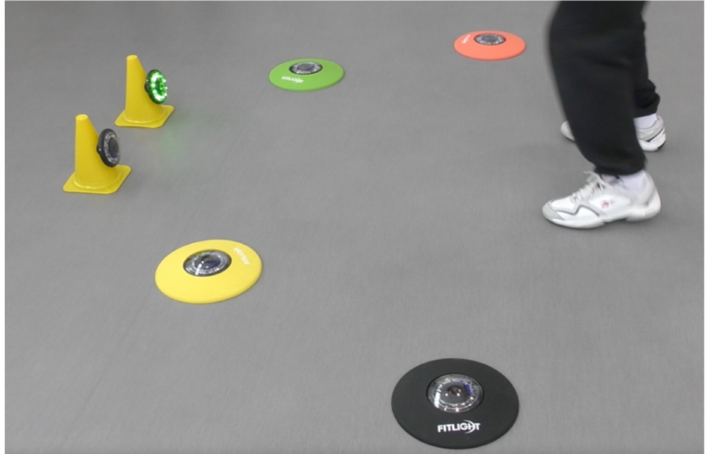
Figure 4. FitLight ® s embedded in colored rings. Subjects stand in between to dampen a light by moving a leg over it or close to it. The experimental set-up is displayed in Appendix